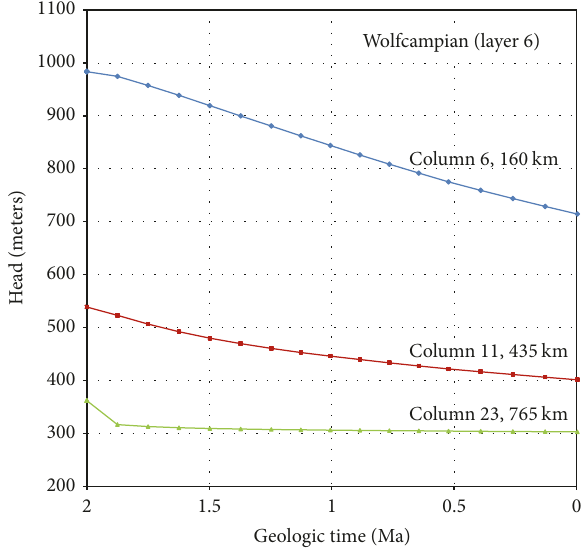
Figure 33: Head versus time for Wolfcampian cells in columns 6, 11, and 23 of the 0Ma model, representing the period from 2 to 0 Ma. At 0 Ma, the solution has equilibrated at the eastern part of the cross- section but has not reached steady state in the central and western parts of the